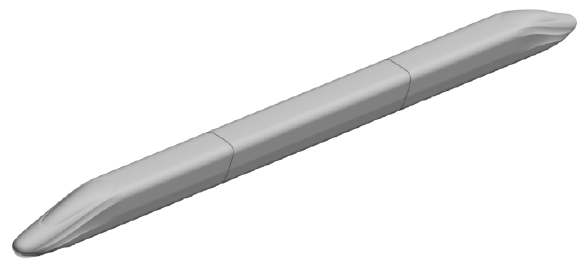
Figure 6. The whole train model.